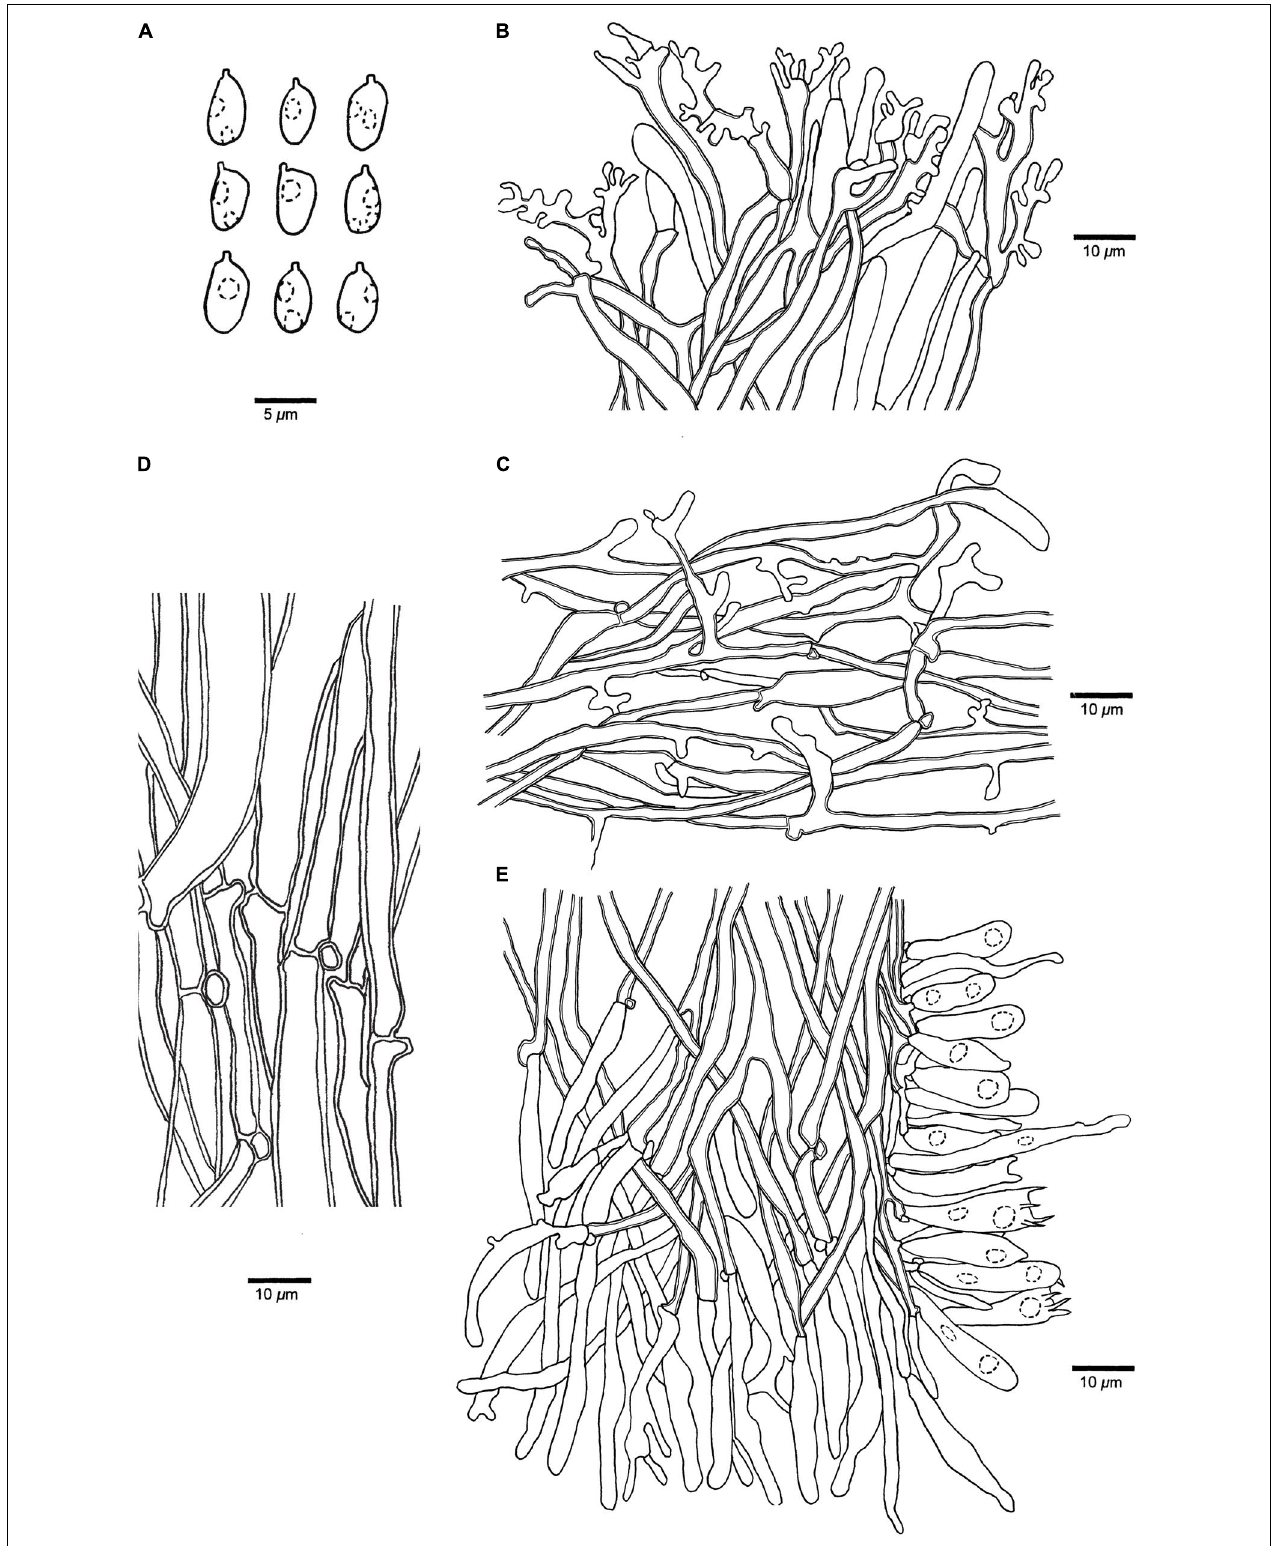
FIGURE 5 | Microscopic structures of Panellus alpinus (holotype). (A) Basidiospores. (B) Dichophysial hyphae and pileocystidia from pileipellis. (C) Hyphae from pileus. (D) Hyphae from stipe base. (E) A section of tube trama, including pleurocystidia, cheilocystidia, basidia, and basidioles. The dotted circles represent some guttules in basidiospores, basidia or